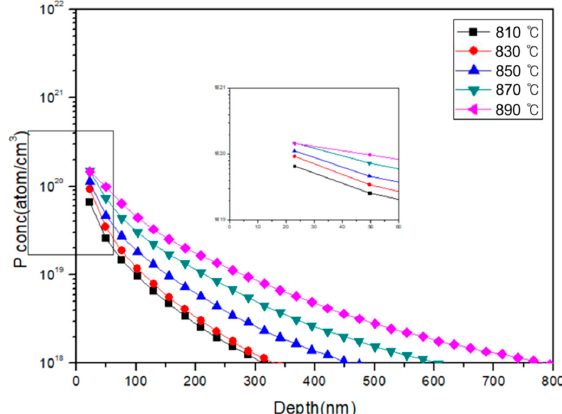
Figure 3. SIMS(Secondary-ion mass spectrometry) profile of the emitter layer with a temperature difference between the pre-deposition and diffusion processes.